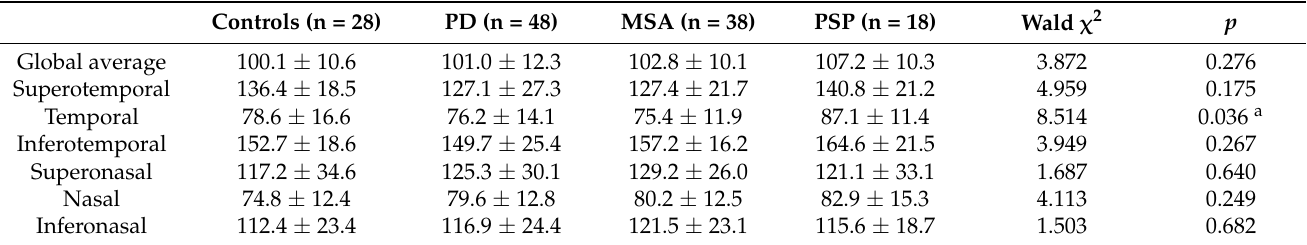
Table 2. Comparisons of peripapillary retinal nerve fiber layer thickness ( μ m) between different groups (3.5 mm diameter).